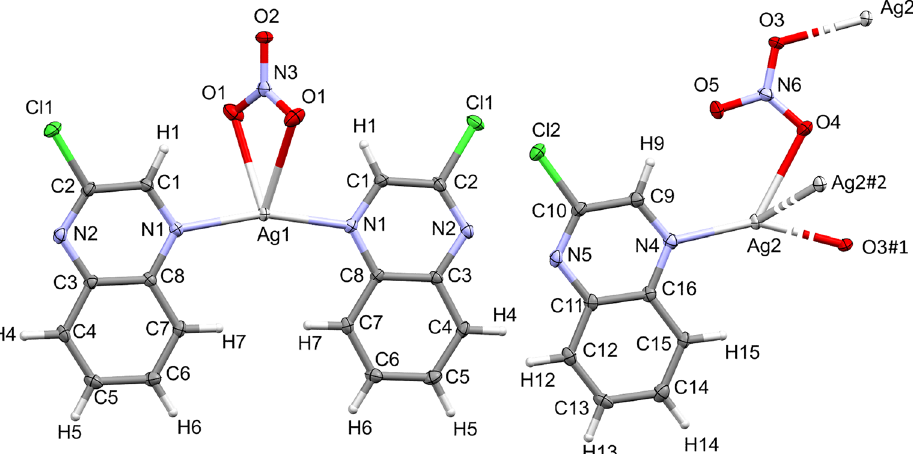
Figure 6. Displacement ellipsoids drawing (50% probability) of 2 , showing the atom-numbering scheme. It consists of two complex units, 2a (left) and 2b (right). The Ag2–O3#1 and Ag2–Ag2#2 bonds in 2b , are shown with a broken line, because the O3#1 and Ag2#2 atoms belong to the neighboring monomer units, but still belong to the coordination sphere of the silver atom. Symmetry codes to generate O3#1 and Ag2#2 are 1/2 − x, − 1/2 + y, − 1/2 − z and 1/2 − z, 1/2 − y, − z,